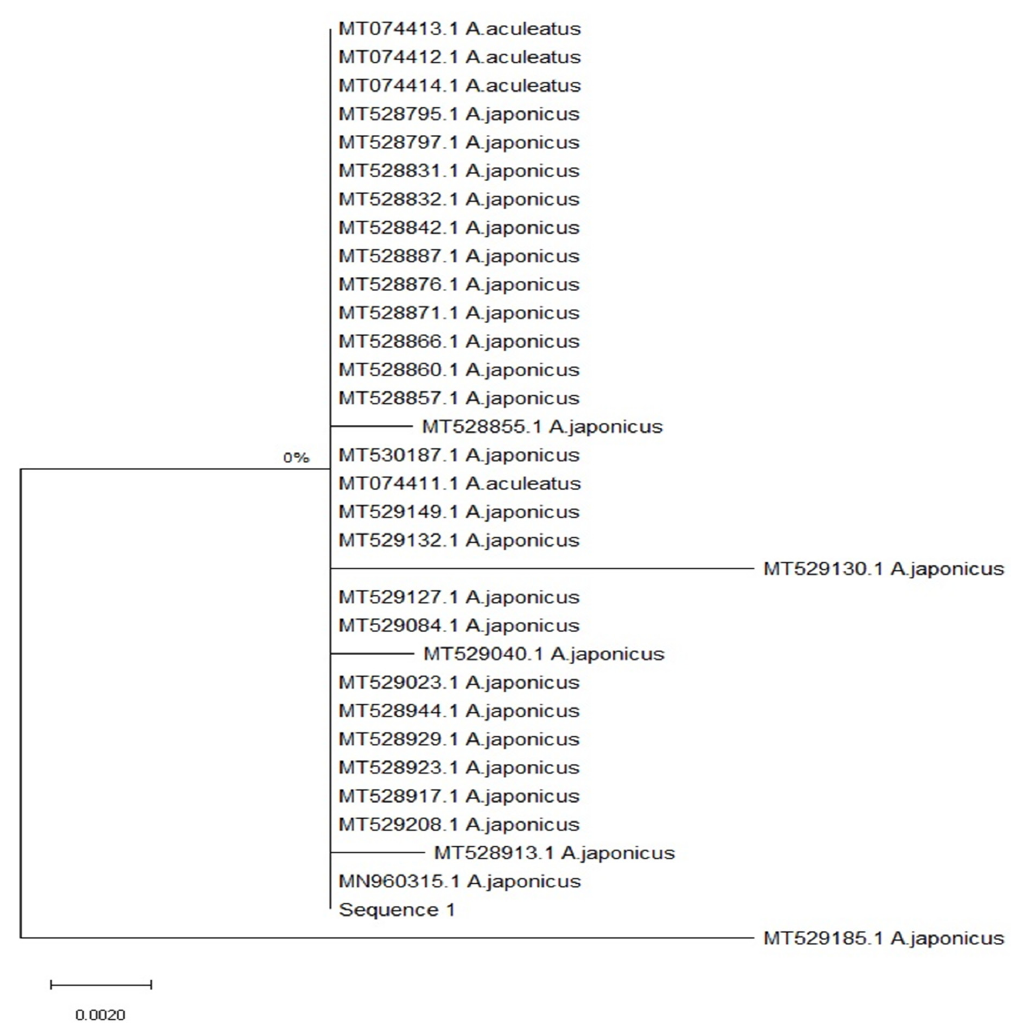
Figure 3. Molecular phylogenetic tree of the partial 18S rRNA sequence of Aspergillus japonicus MN960315.